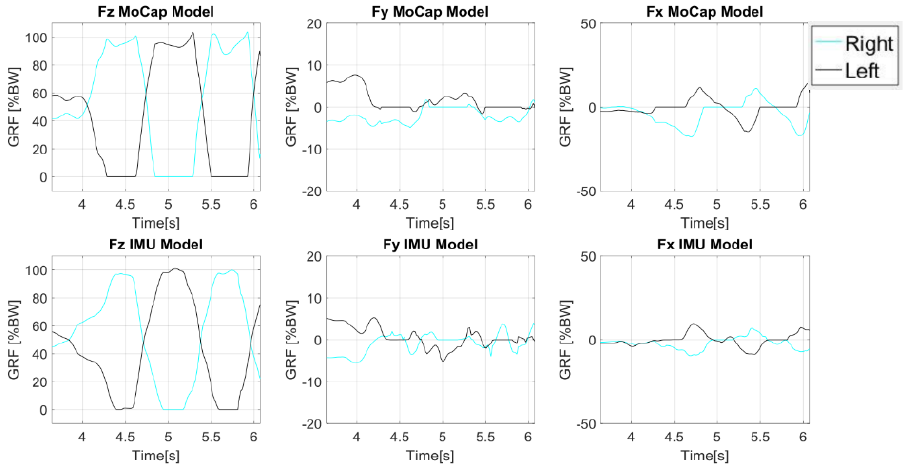
Figure 12. Components of Ground Reaction Forces estimated from the model designed by [60]. On the first row: forces estimated by the OS, on the second row: forces estimated by IMUs.